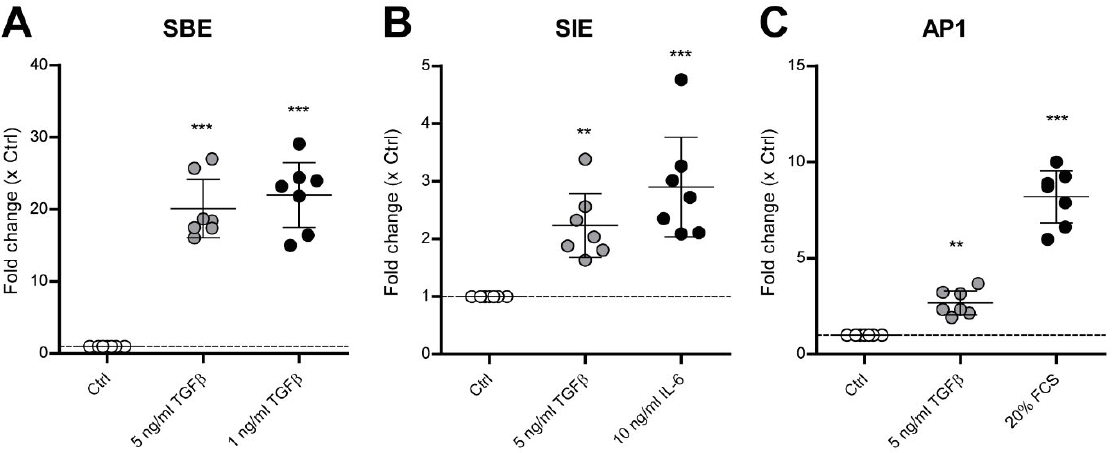
Figure 2. TGF- β 1 activates SMAD3:4, STAT3 and AP1 signaling in human OA chondrocytes. Primary human OA chondrocytes, cultured for a week to form a monolayer, were transduced for 6–8 h with 500 ng of lentivirus per 62,500 cells. After 48 h, the transduced cells were serum-starved overnight and then stimulated with a positive control (black dots) or with 5 ng/mL TGF- β 1 (gray dots) for 6 h. Luminescence was determined at 470–480 nm, and fold change compared to medium-stimulated cells (Ctrl, white dots) was calculated. TGF- β 1 (gray dots) activated cell signaling regulated by the transcription factors ( A )SMAD3:4 (SBE: SMAD binding element), ( B ) STAT3 (SIE: Interleukin(IL)-6 sis-inducible element or STAT3 response element) and ( C ) AP1 (Activation Protein 1). Data are plotted as mean ± 95% CI, with each dot representing the average of a quadruple sample in one chondrocyte donor (total n = 7). Additionally, the induction of the pathways with positive controls is reported (black dots), which were 1 ng/mL TGF- β 1 for the SBE pathway, 10 ng/mL IL-6 for the SIE pathway and 20% fetal calf serum (FCS) for the AP1 pathway. Statistical analysis was performed using one-way ANOVA with Bonferroni’s post hoc test: ** p ≤ 0.01; *** p <